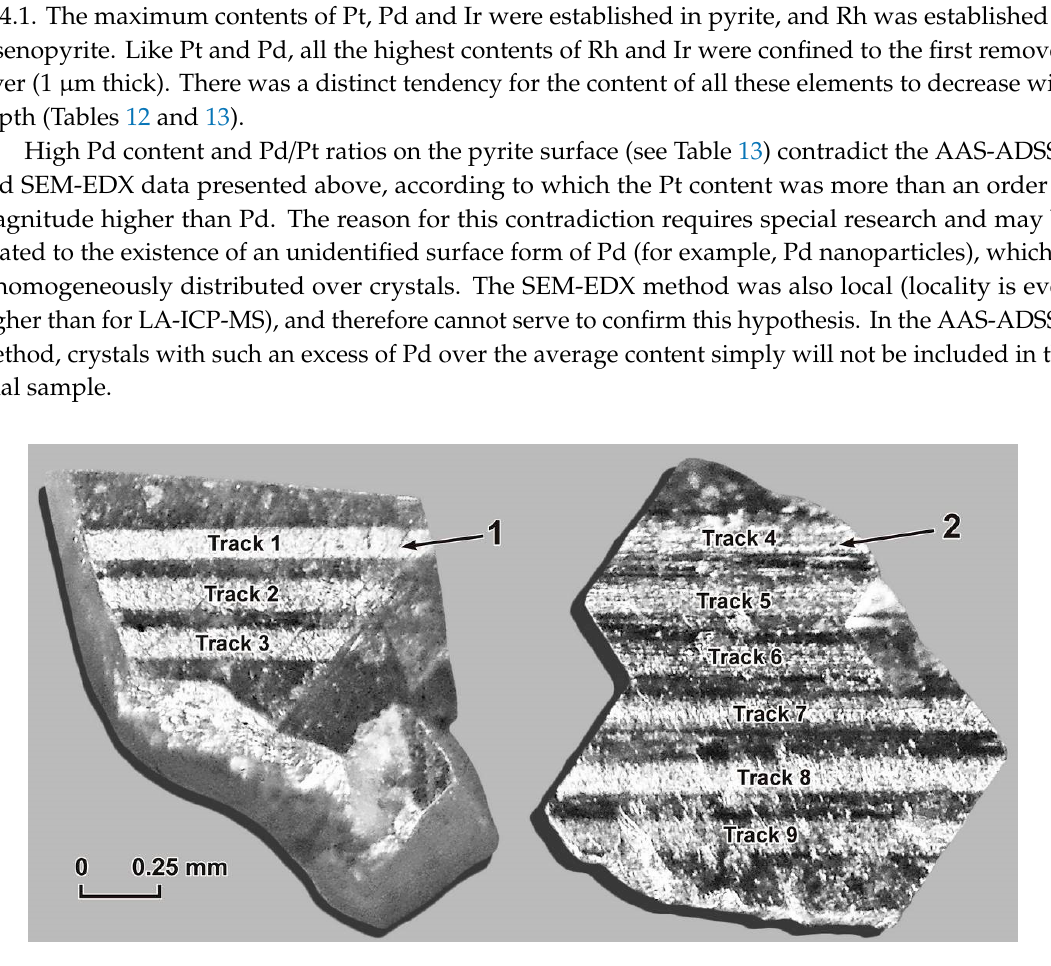
Figure 13. Pyrite Crystals 1 and 2 (sample UV-3/13) from ores of the Natalkinskoe deposit. Tracks 1– 8, numbers of laser passes over the crystal surface. The results of LA-ICP-MS analysis are presented in Table 13. High Pd content and Pd/Pt ratios on the pyrite surface (see Table 13) contradict the AAS-ADSSC and SEM-EDX data presented above, according to which the Pt content was more than an order of magnitude higher than Pd. The reason for this contradiction requires special research and may be related to the existence of an unidentified surface form of Pd (for example, Pd nanoparticles), which is inhomogeneously distributed over crystals. The SEM-EDX method was also local (locality is even higher than for LA-ICP-MS), and therefore cannot serve to confirm this hypothesis. In the AAS- ADSSC method, crystals with such an excess of Pd over the average content simply will not be included in the final sample.